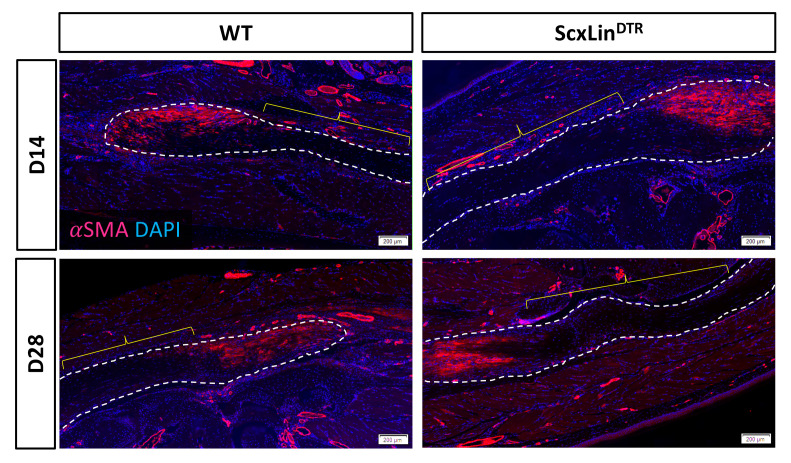
Specific localization of αSMA staining at the tendon repair site.To demonstrate that the myotendinous release, which is incorporated as part of the surgical procedure to decrease the risk of repair rupture, does not lead to tendon degeneration, αSMA staining adjacent to the repair site was examined. An absence of αSMA was observed proximal/ distal to the repair site (yellow bracket). Tendon stubs are outlined in white. N = 4 per genotype per timepoint.